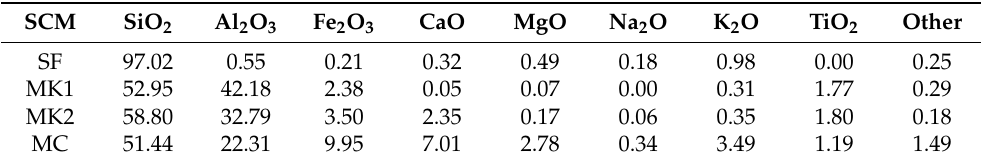
Table 1. Chemical composition of SCMs in wt.% (evaluated on pressed tablets by X-ray fluorescence analysis).